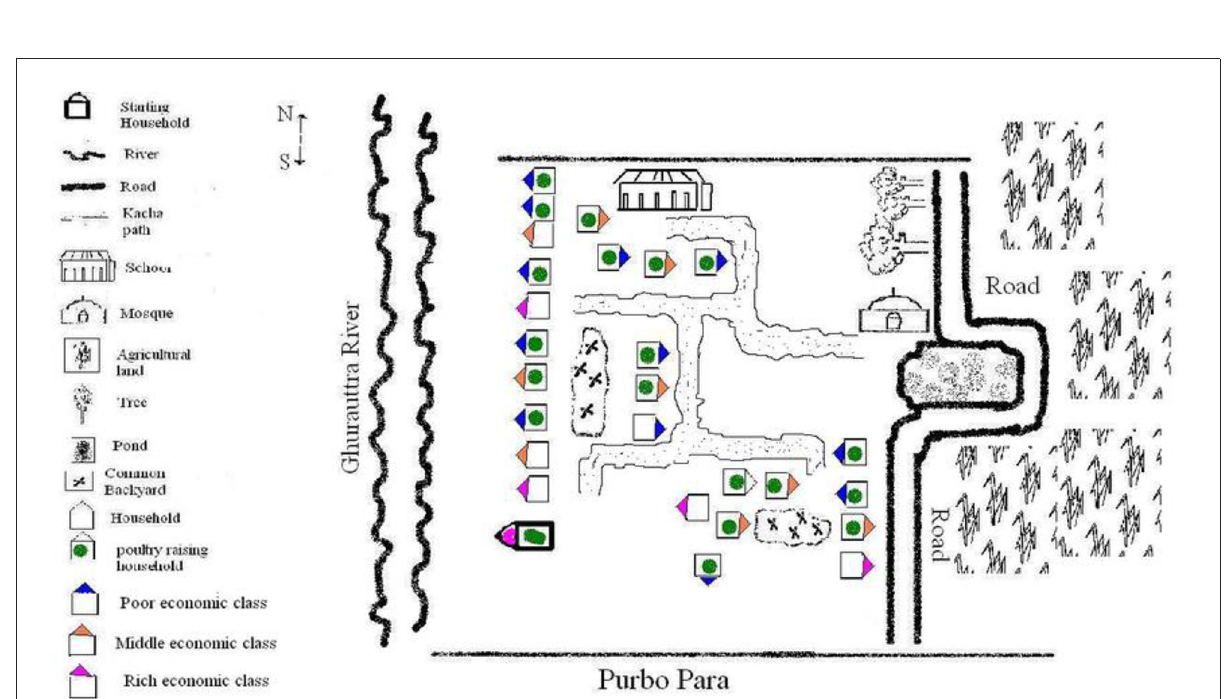
FIGURE2 Social/natural resource map (picture of social mapping of “Purba para” in Netrokona, Bangladesh